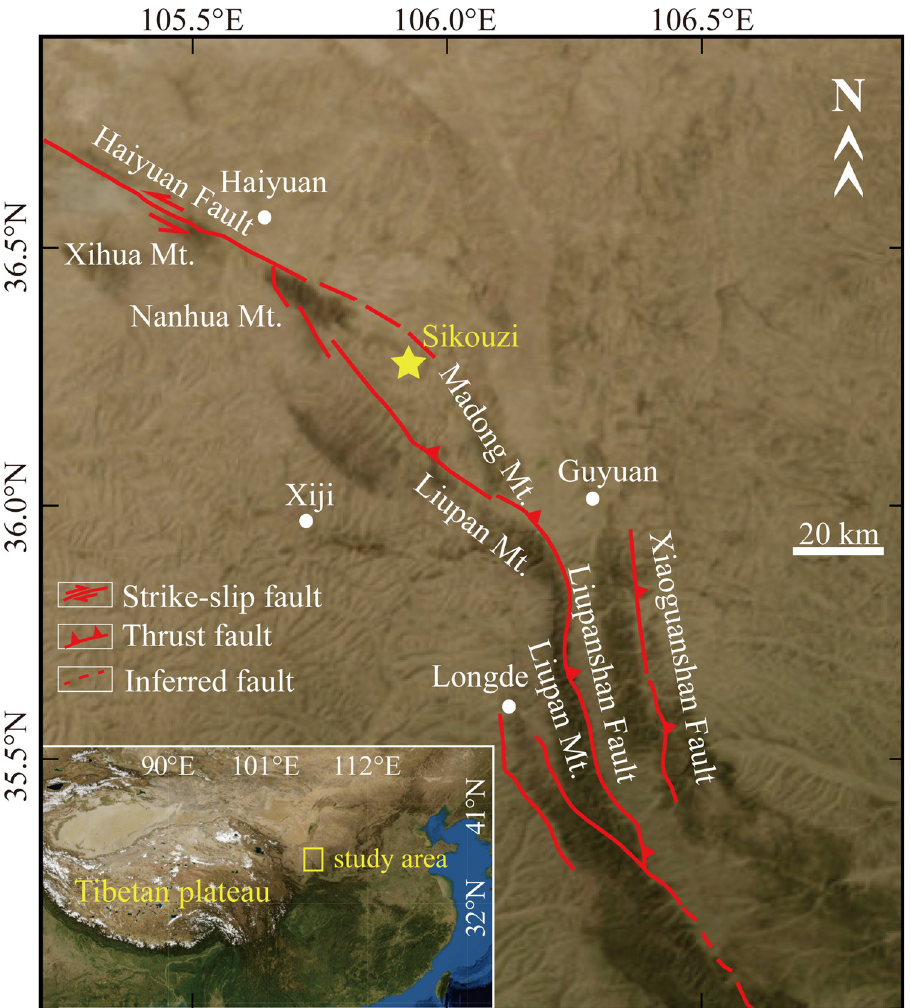
Fig 1. Tectonic setting of Sikouzi Section, Guyuan, Ningxia, China (satellite images download from USGS National Map Viewer (public domain): http://viewer.nationalmap.gov/viewer/; Fault data were from China Earthquake Data Center: